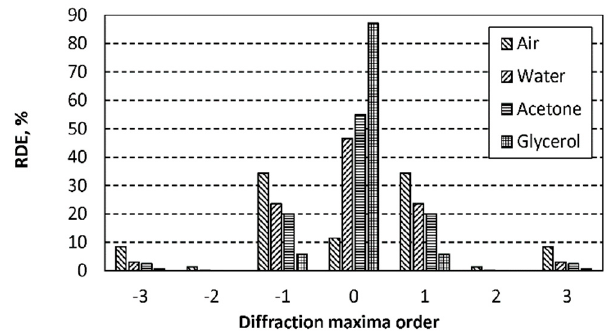
ff raction e ffi ciencies of the reflected light from Al periodic Figure 19. Relative diffraction efficiencies of the reflected light from Al periodic microstructure. Figure 19. Relative di